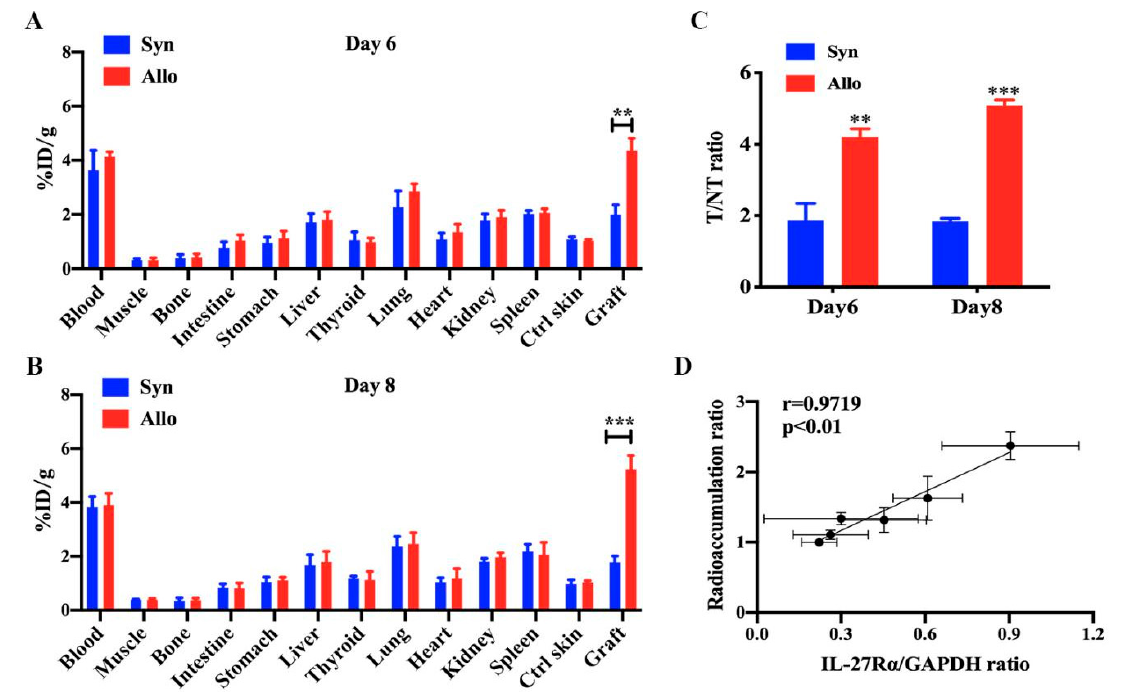
Figure 6. The ex vivo biodistribution and T / NT ratio on day 6 and day 8 post transplantation. The graft and main organs were isolated from syngeneic and allogeneic grafted mouse models on day 6 and day 8, and the biodistribution and T / NT ratio was detected. ( A , B ). Biodistribution assay of syngeneic and allogeneic grafted mouse models on day 6 ( A ) and day 8 ( B ). ( C ). The T / NT ratio of syngeneic and allogeneic grafts. ( D ). Correlation between radioactivity accumulation (the DLU / mm 2 ratio) of the graft to the opposite control skin and the expression of IL-27 R α in allogeneic grafts on day 6, 8 and 10. ** p < 0.01, *** p < 0.001 vs. syngeneic group.